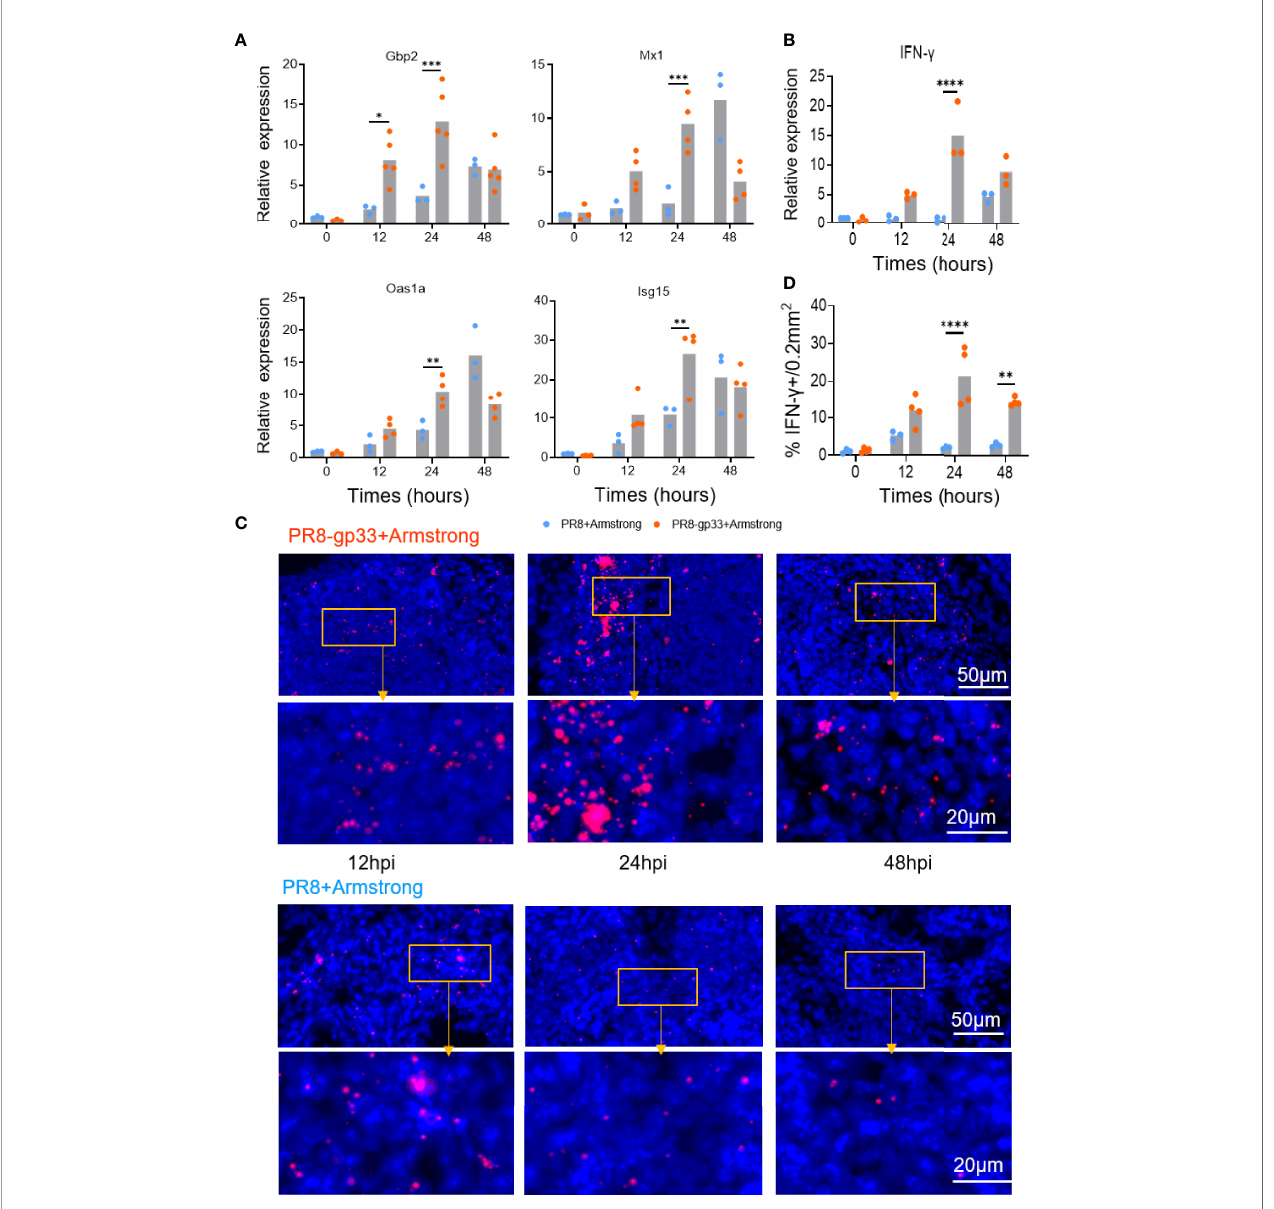
FIGURE 4 | Validation of microarray data by RT-PCR and RNAscope in situ hybridization. (A, B) Animals were treated following the same scheme shown in Figure 3 , and lungs were collected at the indicated time points after LCMV Armstrong challenge for quantitative RT-PCR analysis of mRNA expression of four representative ISGs (A) and lung IFN- g (B) . (C, D) Dynamics of lung IFN- g mRNA determined by RNAscope in situ hybridization, with representative lung sections shown in (C) and quanti fi cation data shown in (D) . Data are representative of two or three independent experiments. * p < 0.05, ** p < 0.01, *** p < 0.001, **** p < 0.0001; two-way ANOVA (A, B, D)